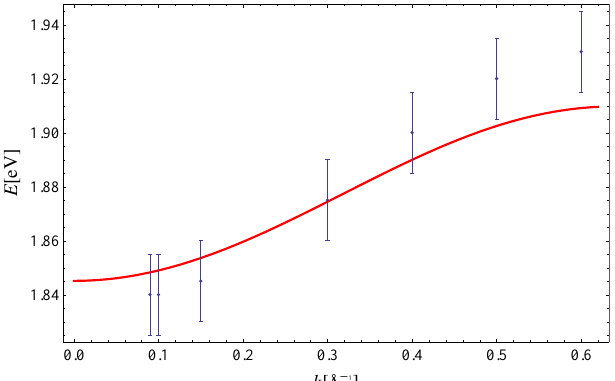
Figure 9. Exciton dispersion along the ( 110 ) direction. Experimental data are taken from Reference [10]. The theoretical curve is obtained for: ∆ = 1.90 eV [33], I x